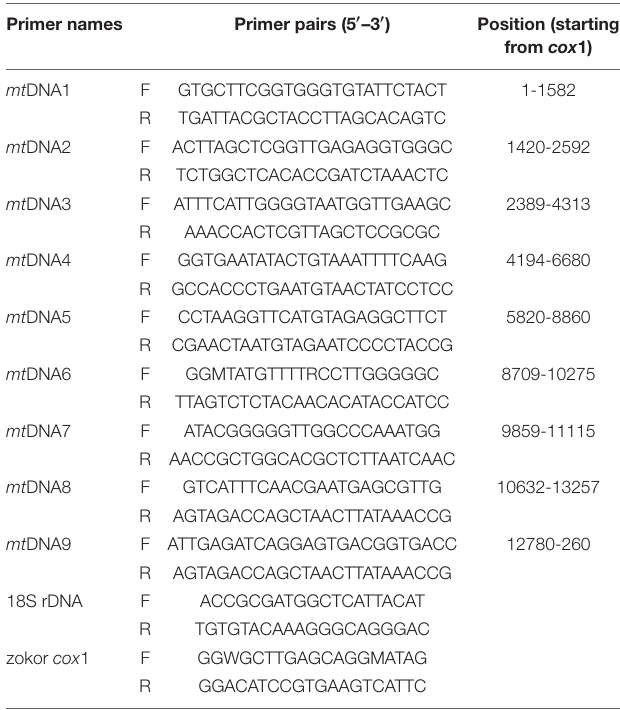
TABLE 1 | List of primer pairs used in the amplification of the complete mitochondrial genome and gene of the parasite and the host’s cox 1 gene. Primer names Primer pairs (5 (cid:48) –3 (cid:48)